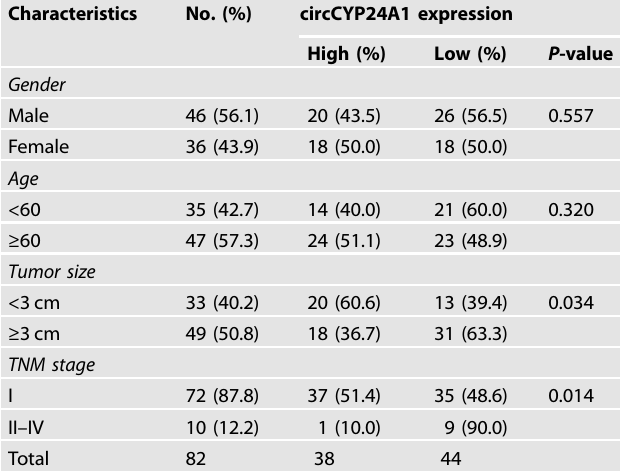
Table 1. Relationship between the expression levels of circCYP24A1 and clinicopathological features in